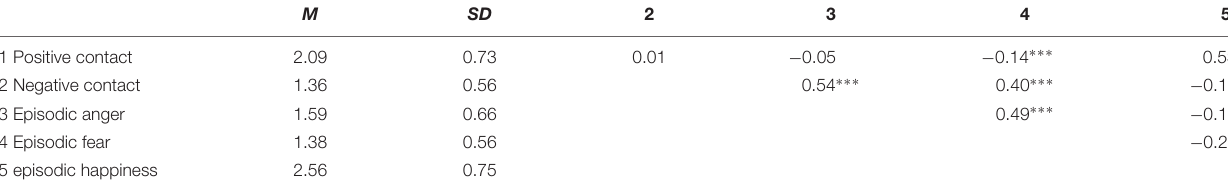
TABLE 1 | Means, standard deviations, and intercorrelations of measures for Study 1.